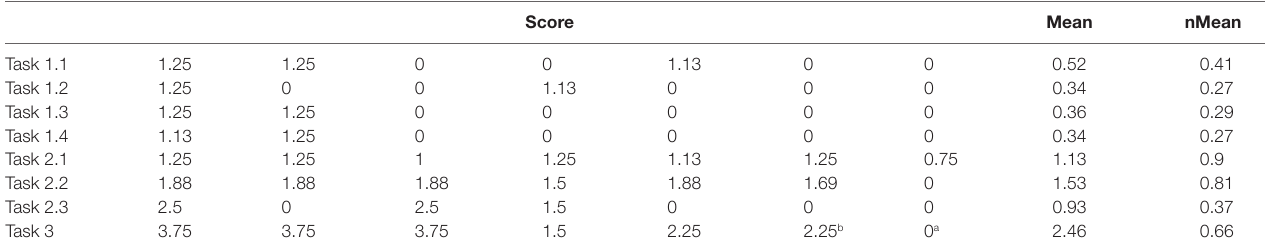
score Mean nMean